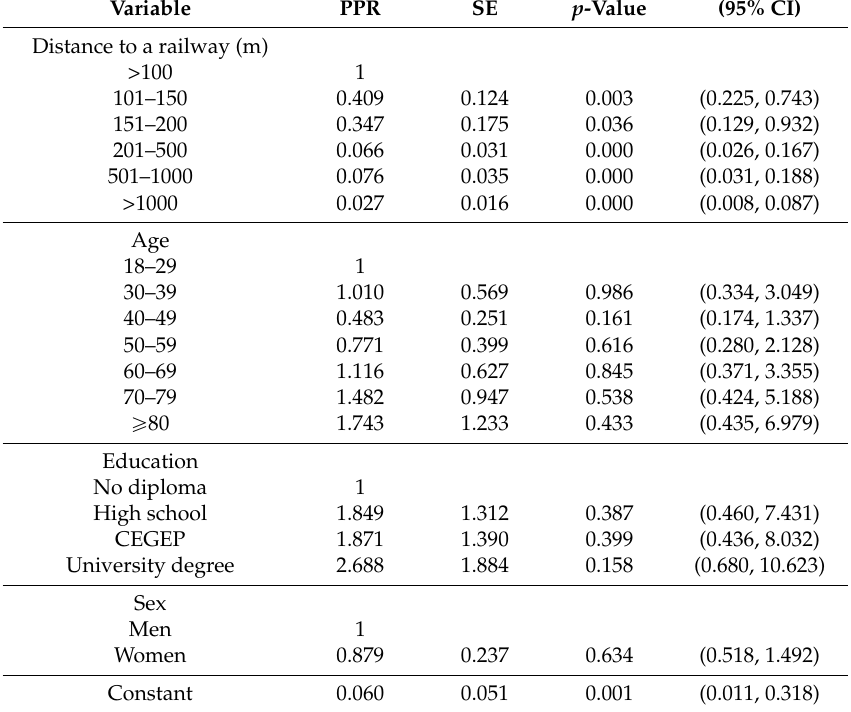
Table A3. Log-binomial regression models for sleep disturbance due to railways in relation to the distance to railways. All variables are in a same